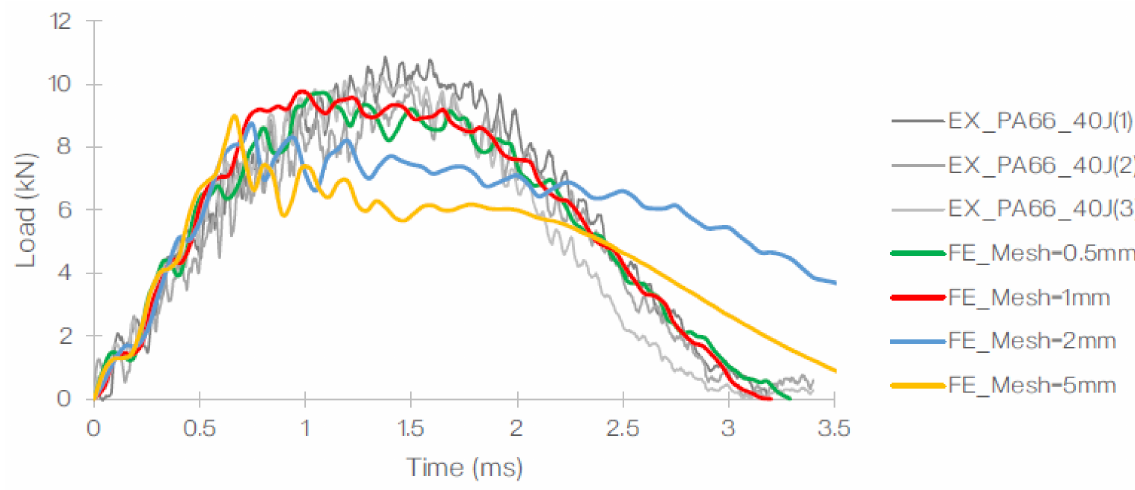
Figure 12. Comparison of the load–time curve obtained from the FE for the 40 J impact event conducted using different mesh sizes against the experiment